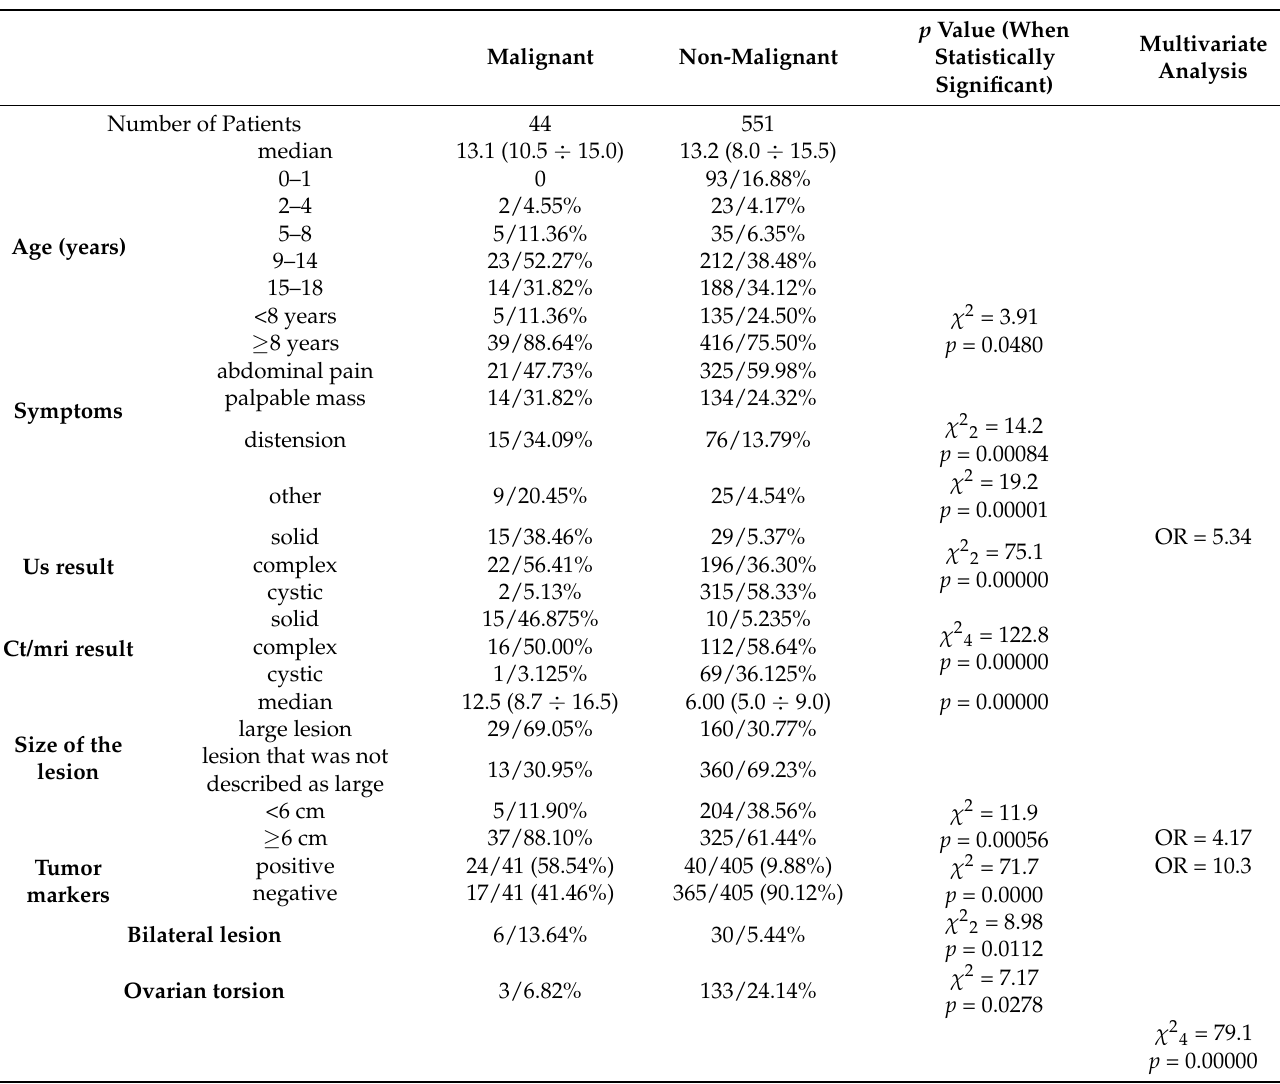
Table 3. Summary of the clinical